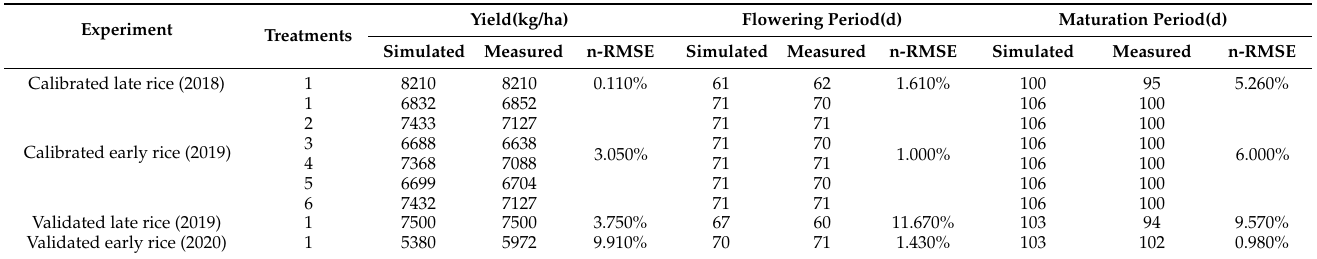
Table 3. Relationship between observed and simulated yield and phenophase of double-harvest